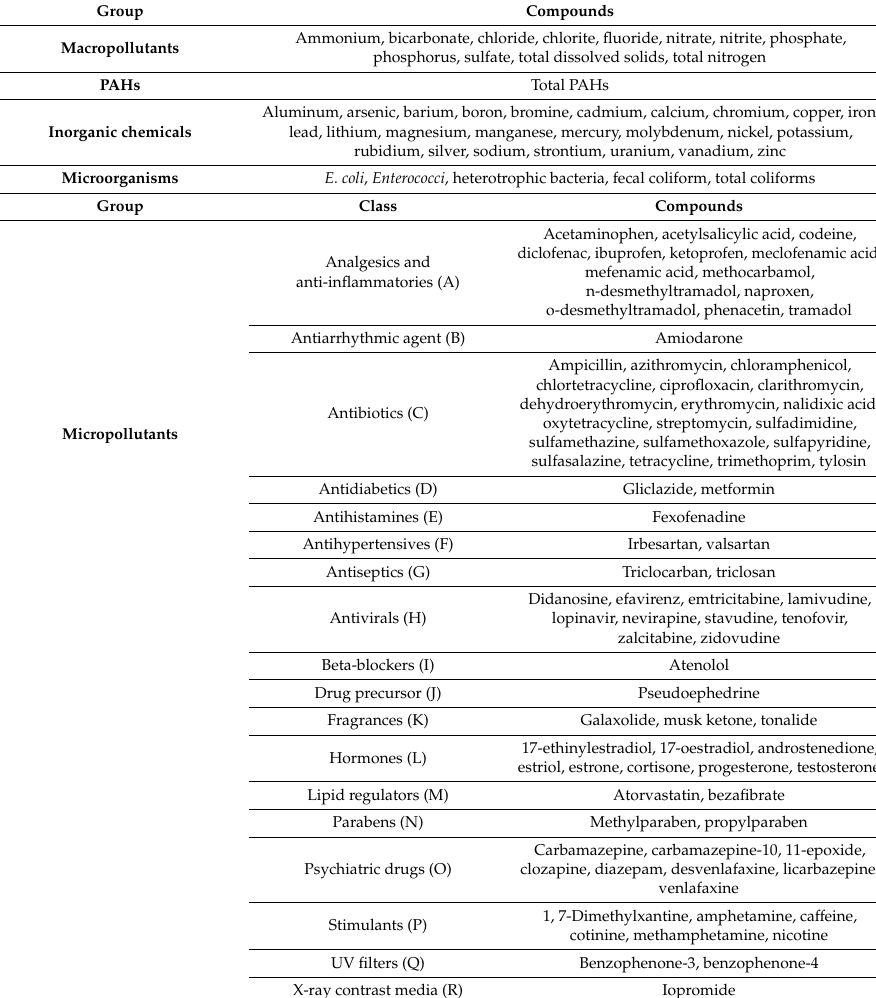
Table 1. Selected macropollutants, polycyclic aromatic hydrocarbons (PAHs), inorganic chemicals, microorganisms, and micropollutants included in the